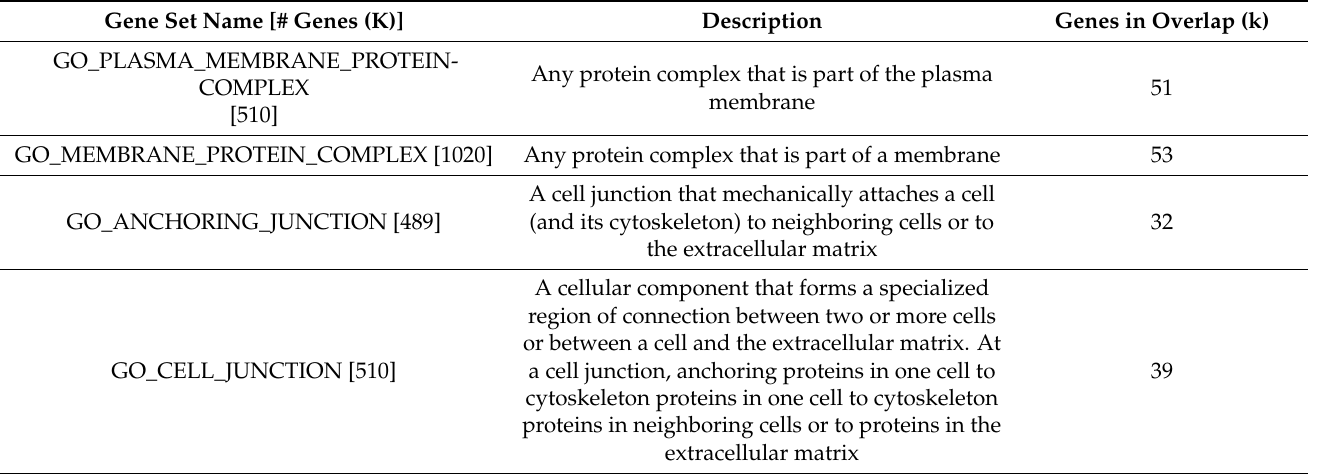
Table 1. Overlapping of cytoskeleton and ARVC genes.